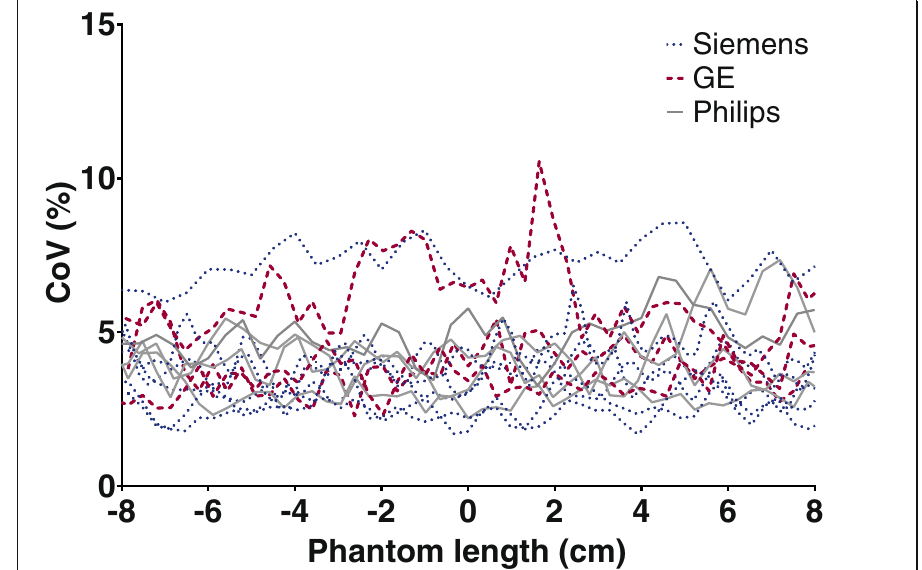
Fig. 2 Noise across the cylindrical phantom filled with 68 Ga, visualized as coefficient of variation